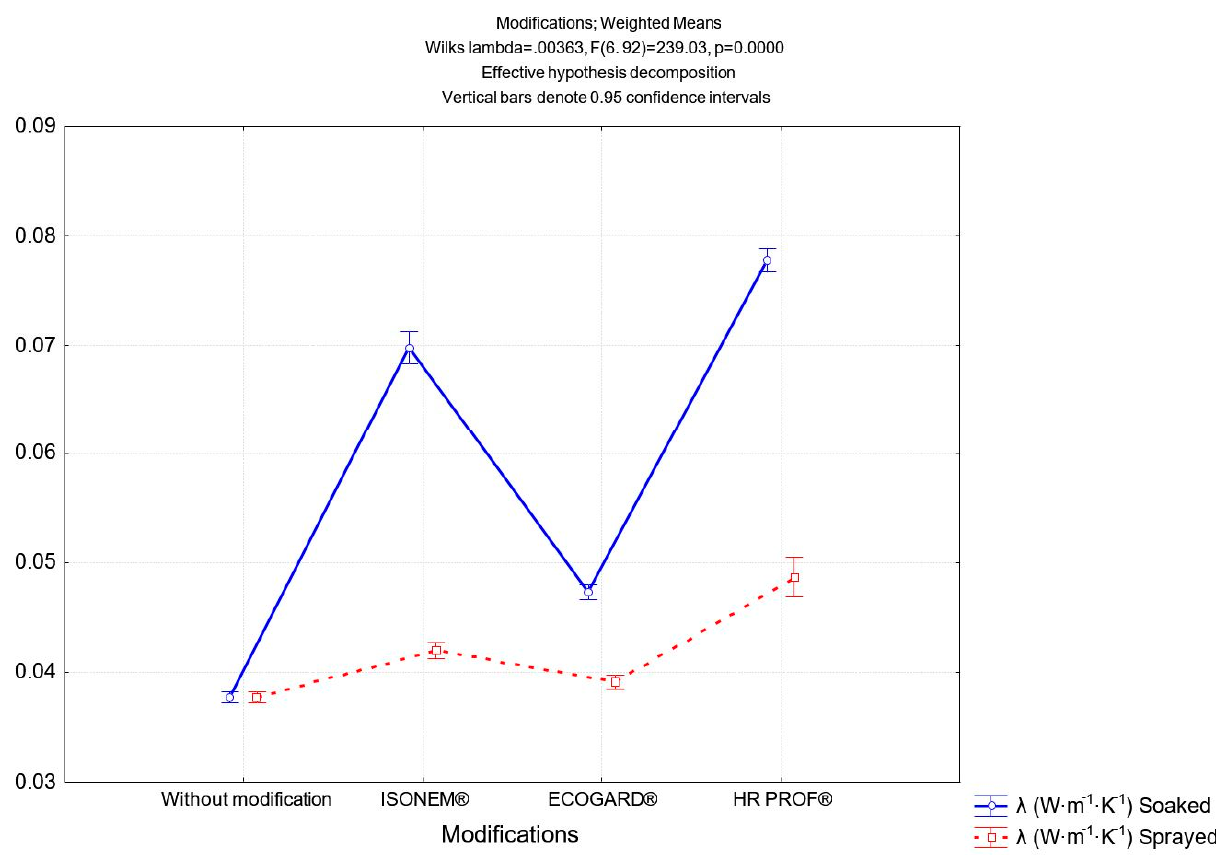
Figure 8. Statistical comparison of thermal conductivity coefficient before and after modification with flame retardants.